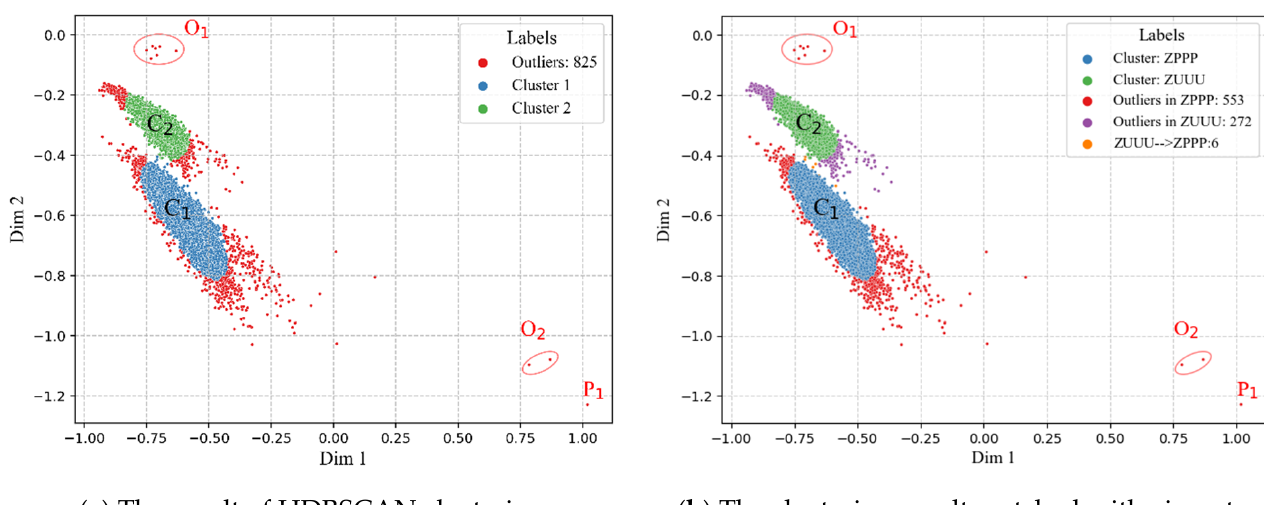
Figure 10. The result of HDBSCAN clustering of flight features.